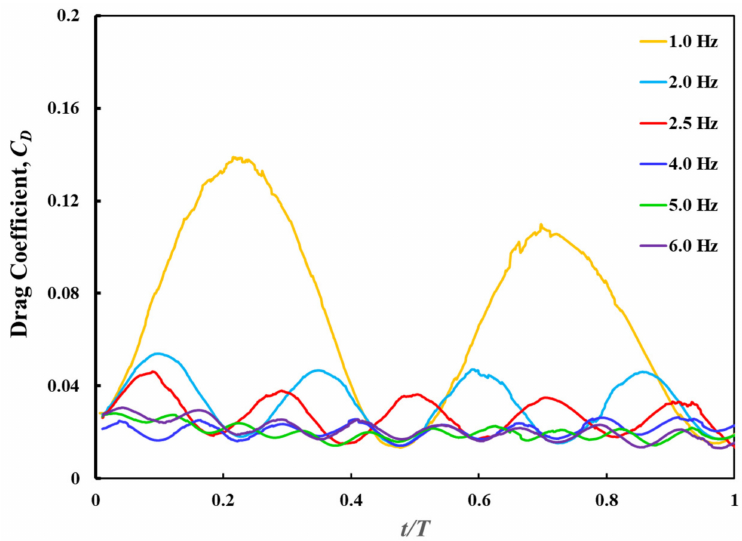
Figure 13. Instantaneous drag coefficient for the station TLC entrained downstream of the obstruction.